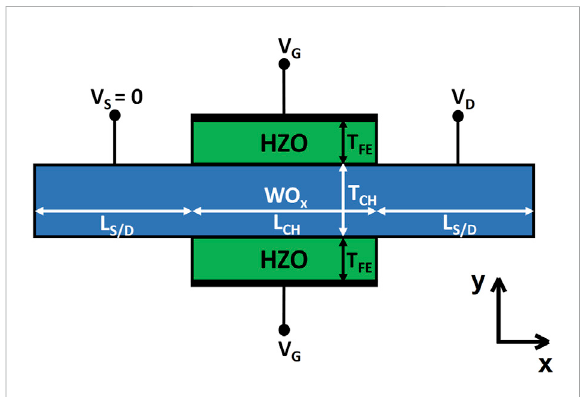
FIGURE 8 Simulated double-gate FeFET structure with a planar WO x channel. Its dimensions are listed in Table 3.